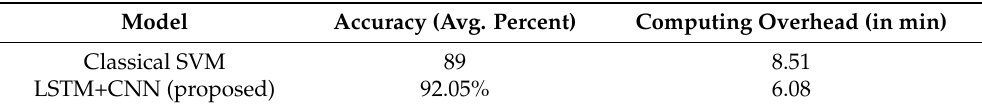
Table 10. Performance of LSTM+CNN (proposed) and classical